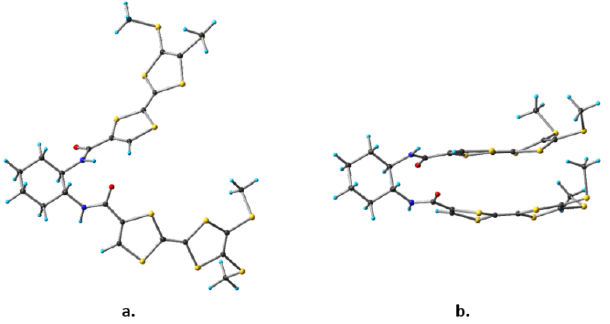
Figure 10. Equilibrium geometries of the neutral compound ( R , R )- 1 , optimized at the following DFT levels: ( a ) B3LYP/Def2-SVPD, ( b ) B3LYP-D3/Def2-SVPD.